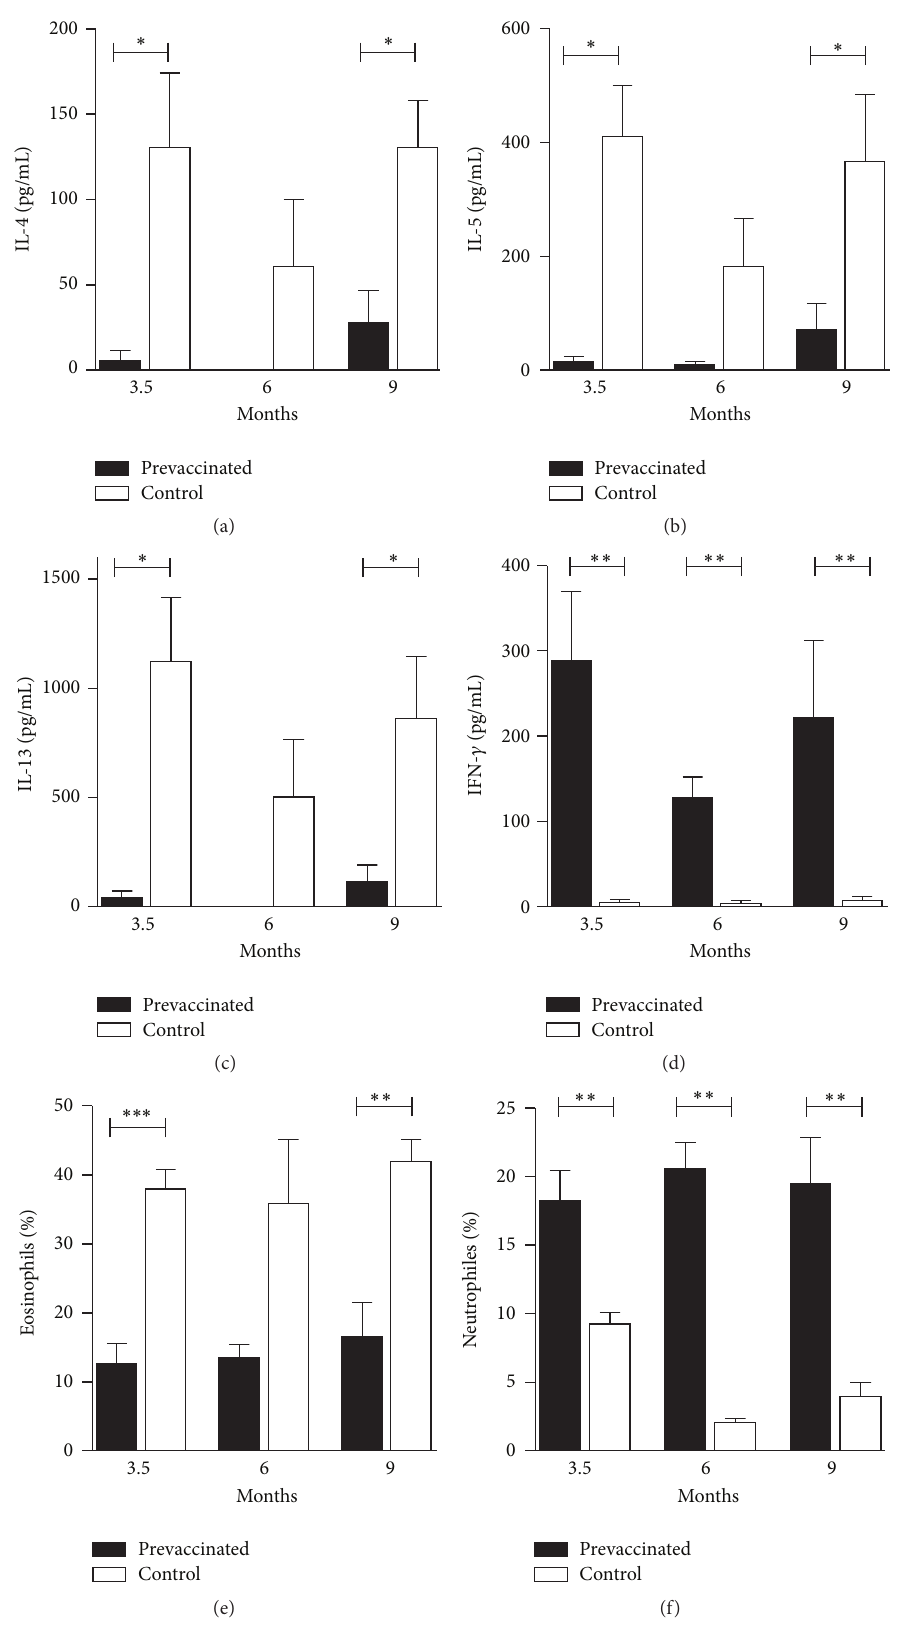
Figure 3: Levels of IL-4 (a), IL-5 (b), IL-13 (c), and IFN- 𝛾 (d) as well as the percentage of eosinophils (e) and neutrophils (f) of total leukocytes in BAL fluids were assessed. Data are shown as means ± SEM ( 𝑛 = 5 ). ∗ 𝑝 < 0.05 ; ∗∗ 𝑝 < 0.01 ; ∗∗∗ 𝑝 < 0.001